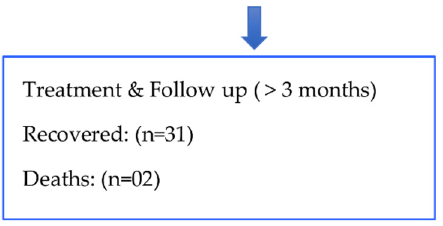
Figure 1. Flow chart depicting the schematic of the study.